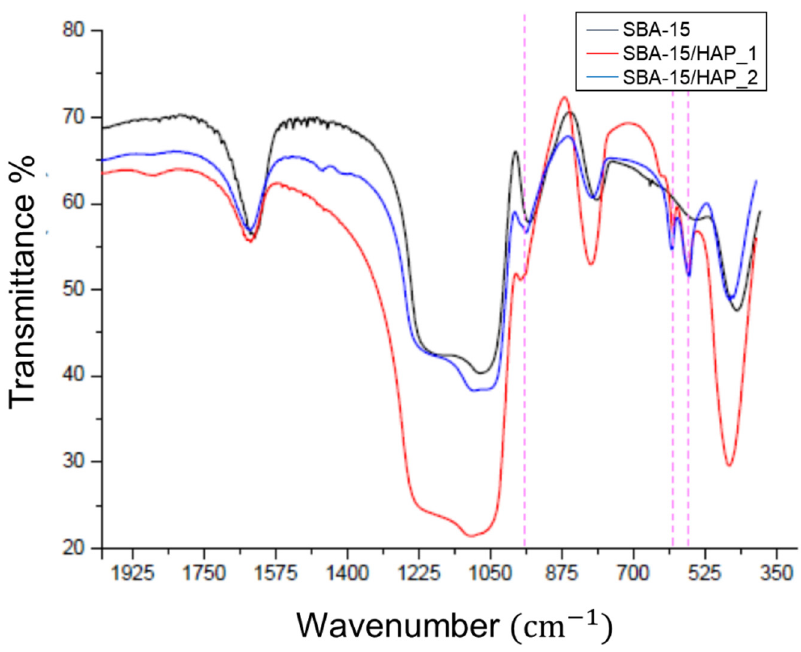
Figure 8. FTIR spectra for calcined SBA-15, SBA-15/HAP_1, and SBA-15/HAP_2 samples.